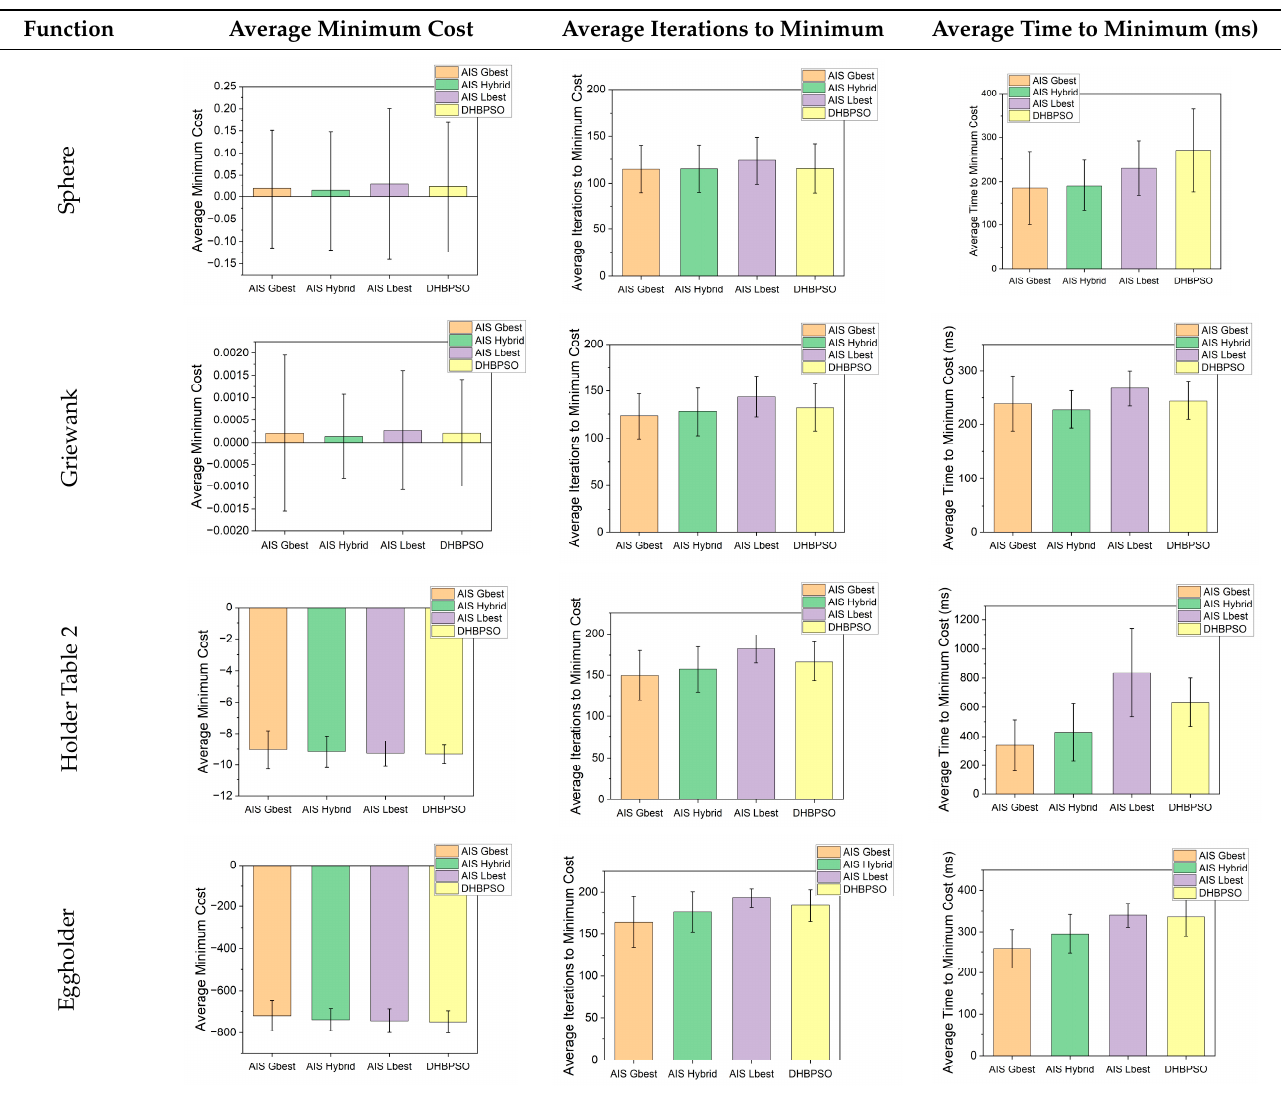
Table 2. Column plots comparing AIS BPSO algorithms solving 100-variable test functions using 10 particles and a maximum iteration of 200 averaged over 500 runs.